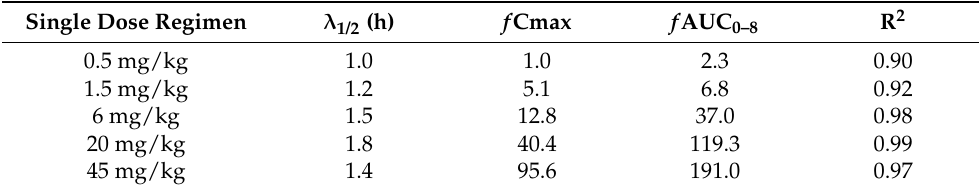
Table 1. Comparison of single dose ceftibuten regimens in mice using non-compartmental analysis.